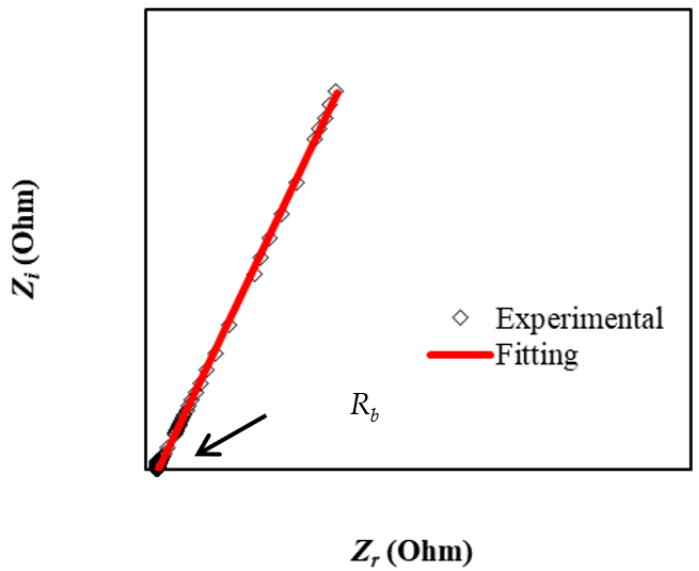
Figure 1. The impedance plot of glycerolized MC:DN:NH 4 SCN:Zn (II) metal complex electrolyte films at ambient temperature.